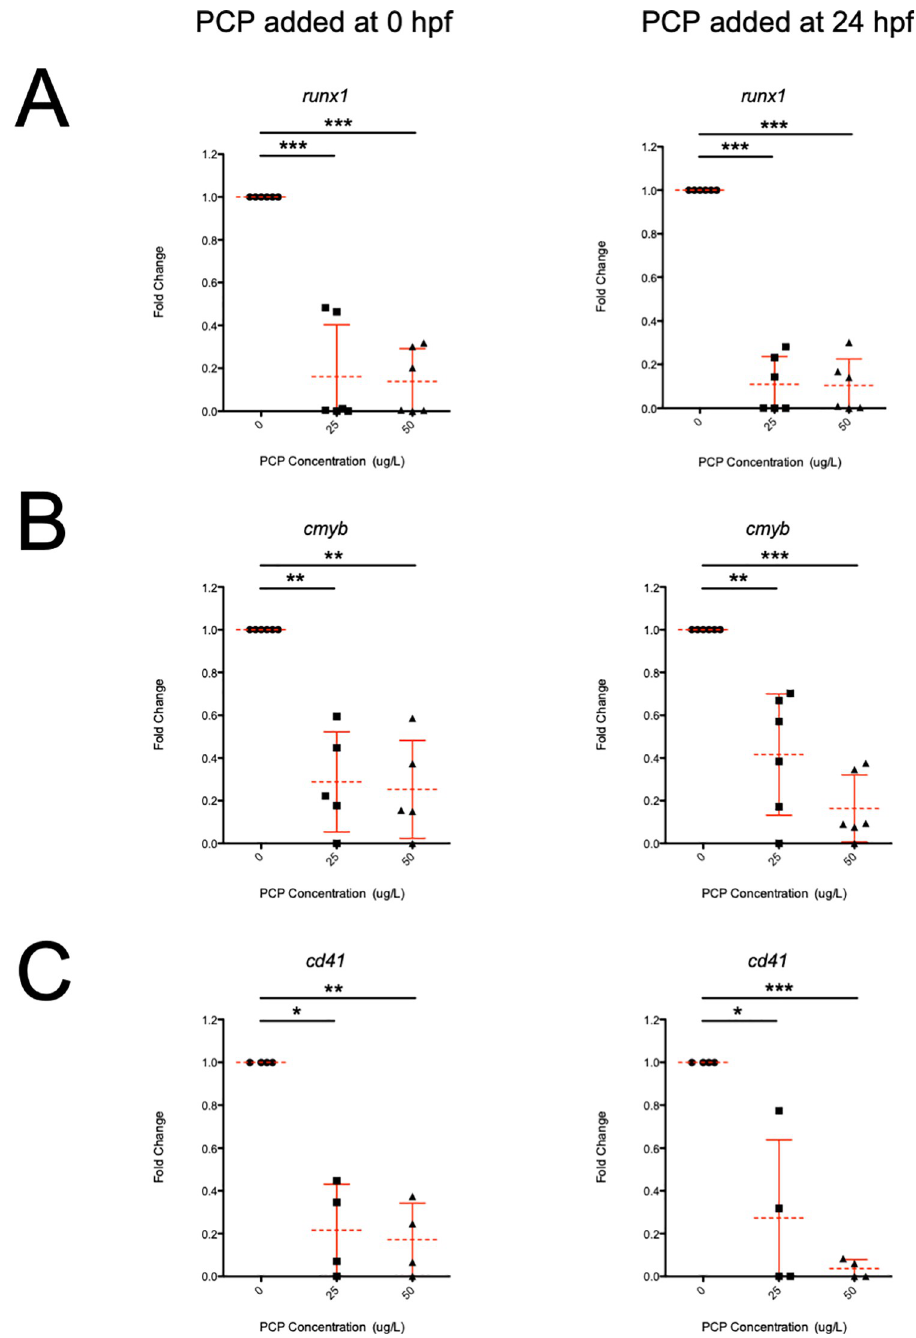
Fig 6. qRT-PCR indicates runx1 , cmyb , and cd41 expression is lower in PCP treated embryos. Embryos were exposed at 0 (left panel) and 24 (right panel) hpf. Embryos were collected and processed at 48 hpf. qRT-PCR for runx1 (A), cmyb (B), and cd41 (C) was performed. Each point represents ten embryos randomly selected from live untreated, (circles) 25 μ g/L (squares), and 50 μ g/L (triangles) PCP conditions. Dashed lines denote mean and error bars represent SD. � denotes p < 0.05, �� denotes p < 0.005, ��� denotes p < 0.001.